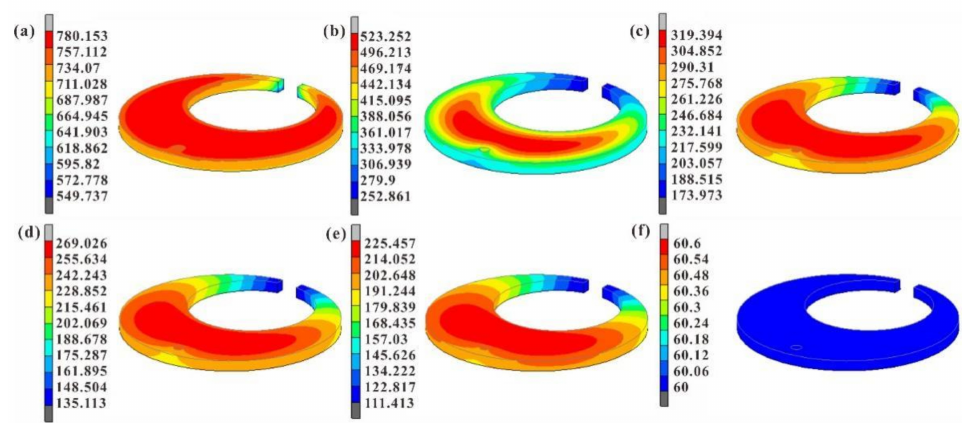
Figure 7. Temperature distribution of simulated predicted 20Cr2Ni4A steel C-type specimens with time: ( a ) 1 s, ( b ) 5 s, ( c ) 10 s, ( d ) 15 s, ( e ) 20 s and ( f ) 126